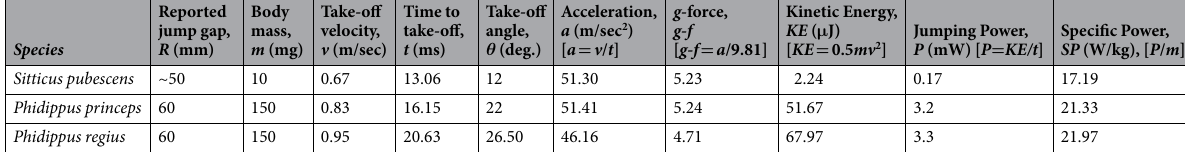
Table 2. Comparison of the jumping performance of Phidippus regius against Sitticus pubescens 19 , and Phidippus princeps 20 . All three jumps are level